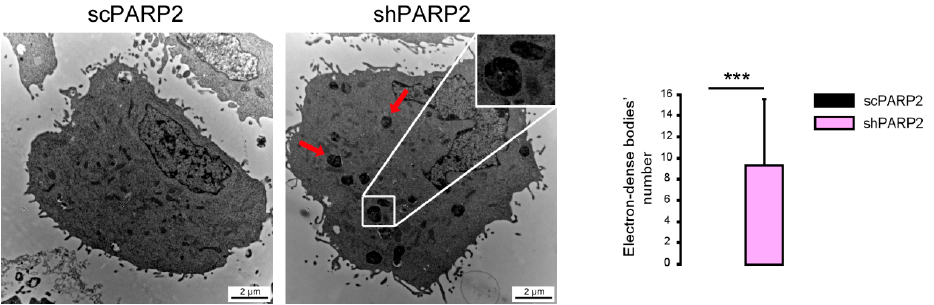
Figure 2. Cytosolic electron-dense particles appear in PARP2-silenced cells. scPARP2 and shPARP2 C2C12 cells were analyzed by electron microscopy ( n = 1, counted cells: 50 / 50). Red arrows and the insert picture show the cytosolic electron-dense particles in shPARP2 cells, which were absent in scPARP2 cells. Cytosolic electron-dense particles were counted in cells and data was plotted. *** represents statistically significant differences between the scPARP2 and shPARP2 cells at p < 0.001. Average ± SD is plotted. As cytosolic electron-dense bodies were absent in the scPARP2 cells, the value for the chart is 0 with no standard deviation.